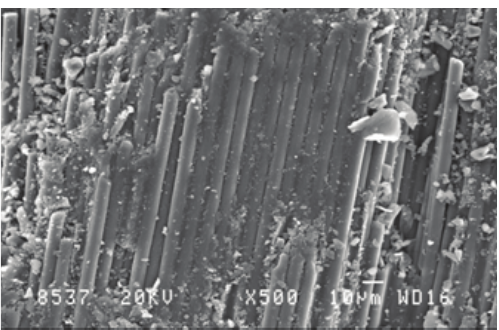
Figure 13: SEM of worn surface of G-E material.